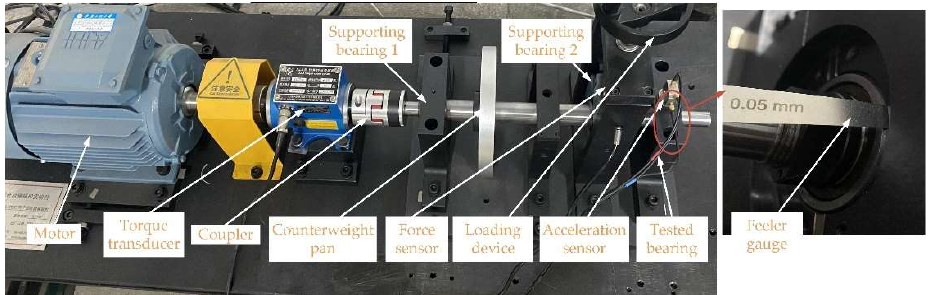
Figure 5. The test rig for the defective bearing with fit clearance.